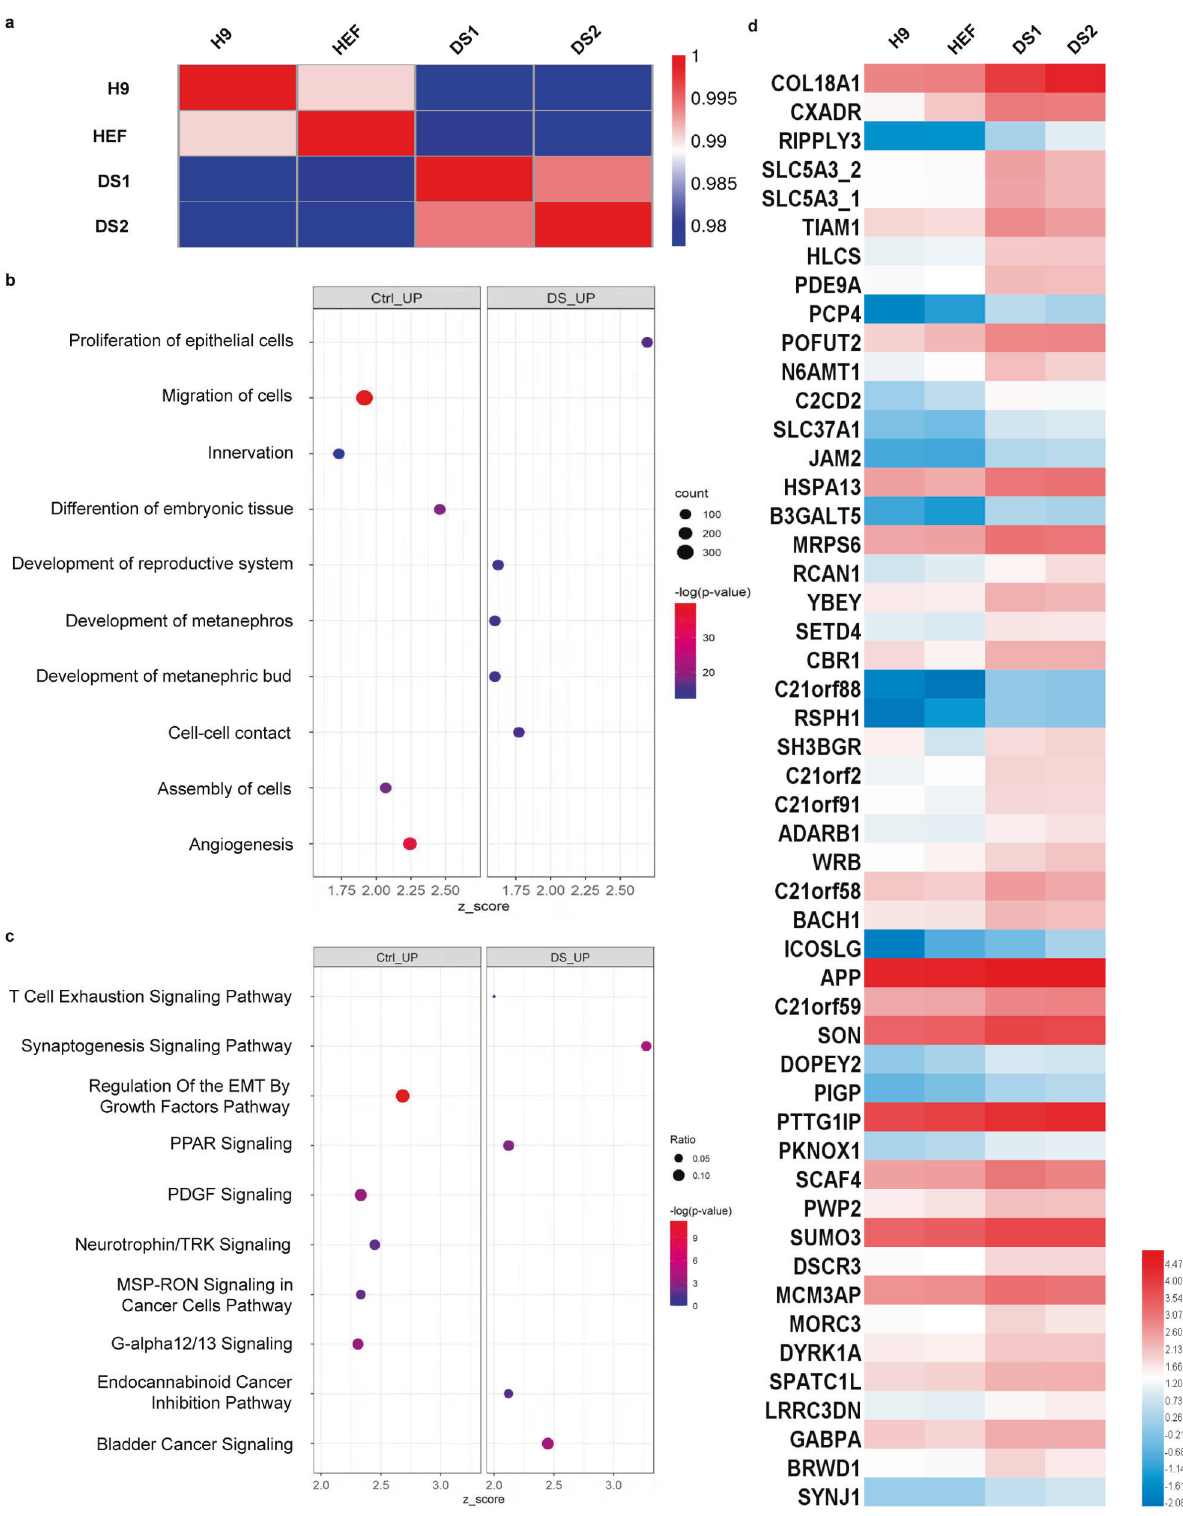
Fig. 4 Genome-wide transcriptional pro fi le analysis of DS-NCSCs. a Pearson ’ s correlation coef fi cients of pairwise comparisons were calculated for all expressed genes in NCSCs derived from the control group and the DS group. b IPA functional annotation of all differentially expressed mRNAs. The dot plot of partially enriched functions. The color intensity of the nodes indicates the degree of IPA function enrichment. The horizontal axis indicates the gene ratio as the proportion of differentially expressed genes in the whole gene set. The size represents the number counts in a certain function. c IPA canonical pathway analysis of all differentially expressed mRNAs. The dot plot of partially enriched pathways. The color intensity of the nodes indicates the degree of canonical IPA pathway enrichment. The horizontal axis indicates the gene ratio as the proportion of differentially expressed genes in the whole gene set. The size represents the number counts in a certain pathway. d The top 50 genes with upregulated expression on HSA21 in the DS group compared to the control group. Cell Death and Disease (2022)